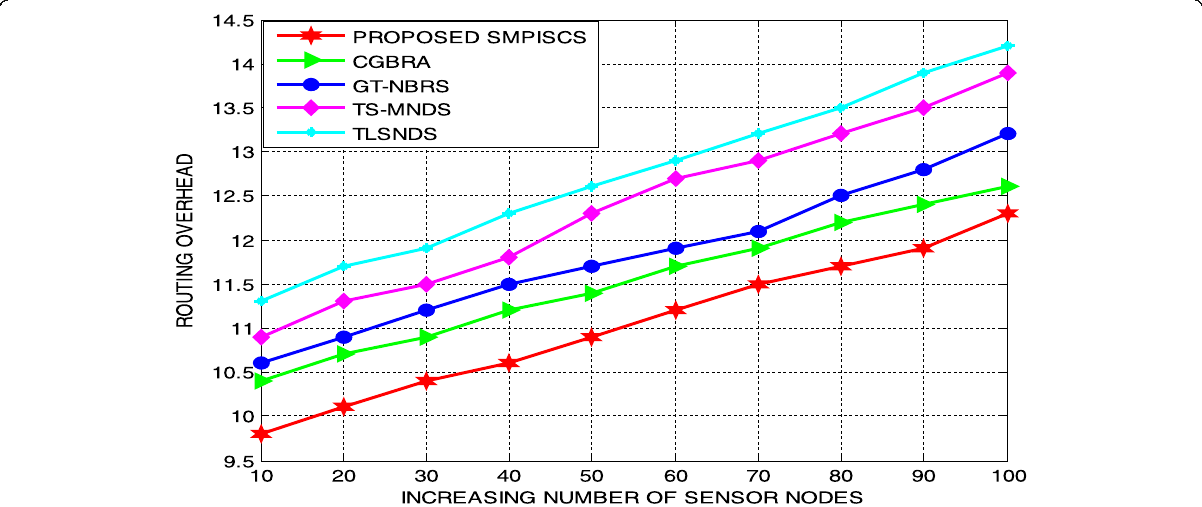
Fig. 5 SMPISCS-Routing Overhead (number of sensor